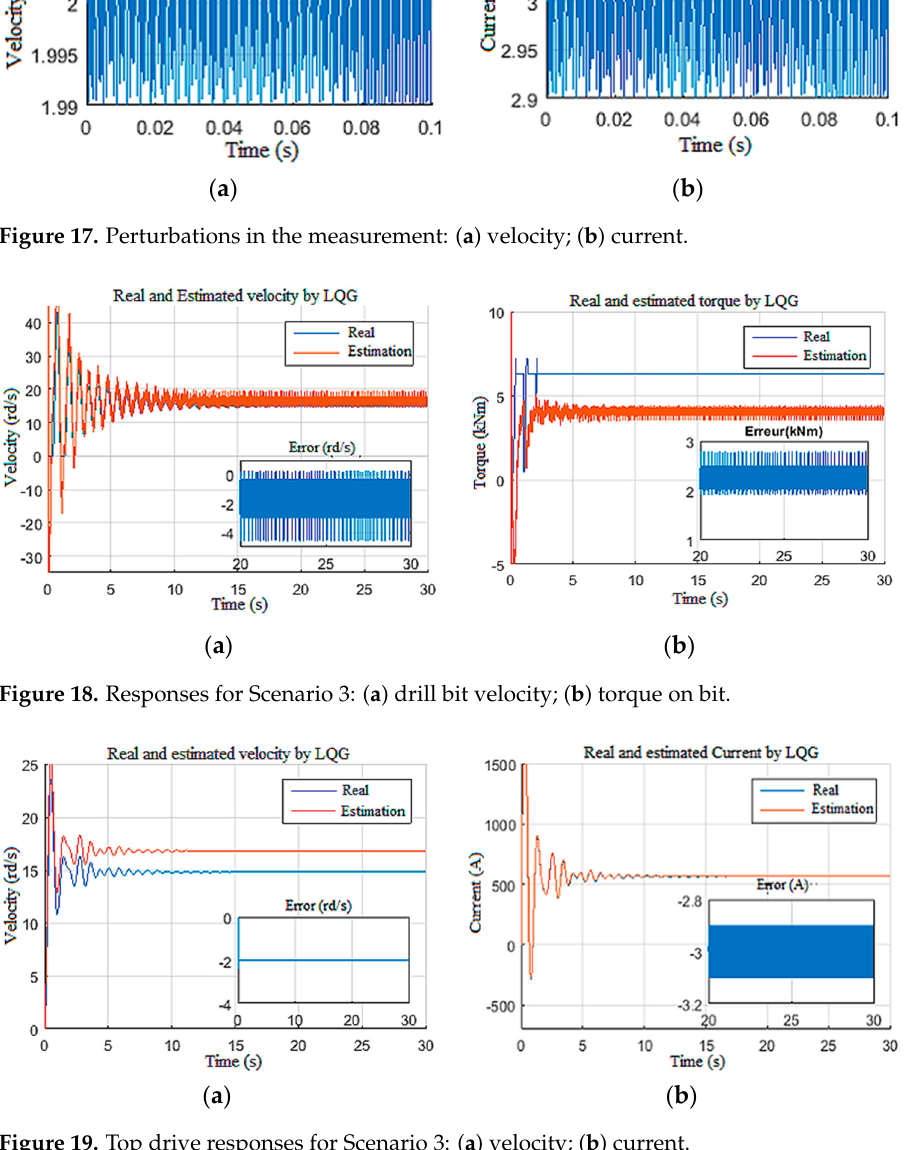
( b ) Figure 20. Outputs of LQG from Scenario 4: ( a ) drill bit velocity; ( b ) Tob. 4.2. Observer-Based Controller’s Performance Tests In this subsection, the full observer-based controller performances were tested, whereby the controller robustness depends strongly on the accuracy of the estimated states provided by the observer [29]. The primary goal of the designed control system is to establish a predefined dynamic on the top drive in such a way that the drill bit pursues the convenient speed reference, which consequently mitigates the torsional vibrations and suppresses levels 2 and 3 of stick-slip vibration in the drill string in the shortest possible time [16]. 4.2.1. Reference Tracking In this scenario, the control system was subjected to an echelon Wob input designed to test the controller robustness against the occurrence of an unknown amplitude disturb- ance. The simulation was initiated with a low Wob (25 kN) and a reference of 7 rd/s. Then, at t = 10 s, the Wob was increased to 180 kN, and the Tob generated by this increase is shown in Figure 21a. This increase caused an abrupt stop of the drill bit, as demonstrated